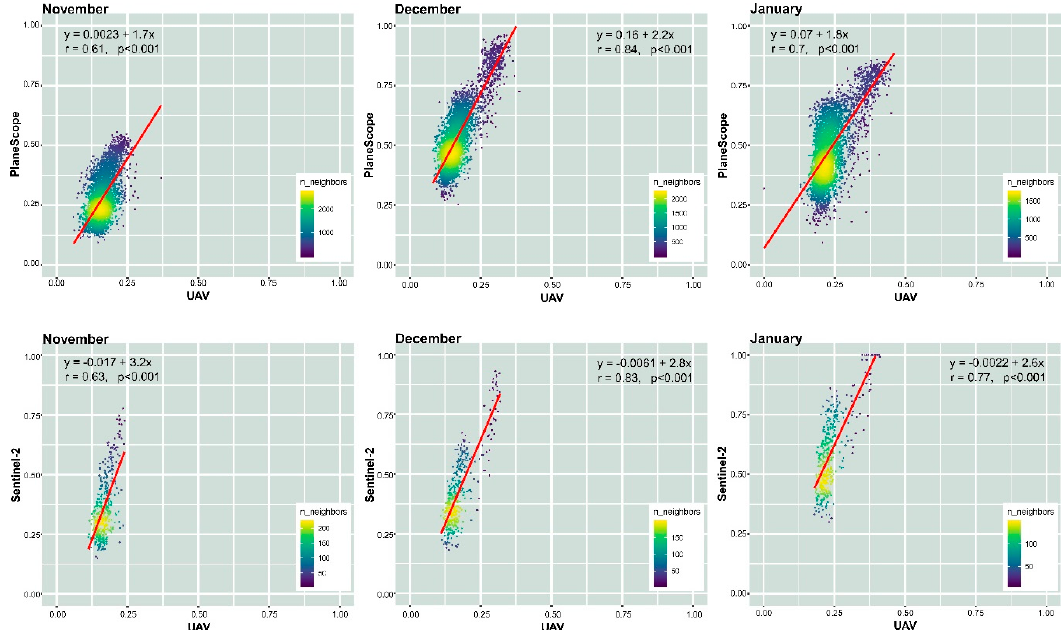
Figure 7. Scatter plots of SAVI values from UAV onions mask (SAVI onions) (x-axis), PlanetScope, and Sentinel-2 maps in the three months surveyed.